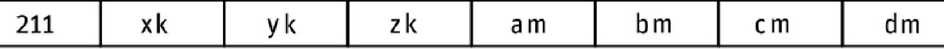
Figure 6. Measurement data frame.